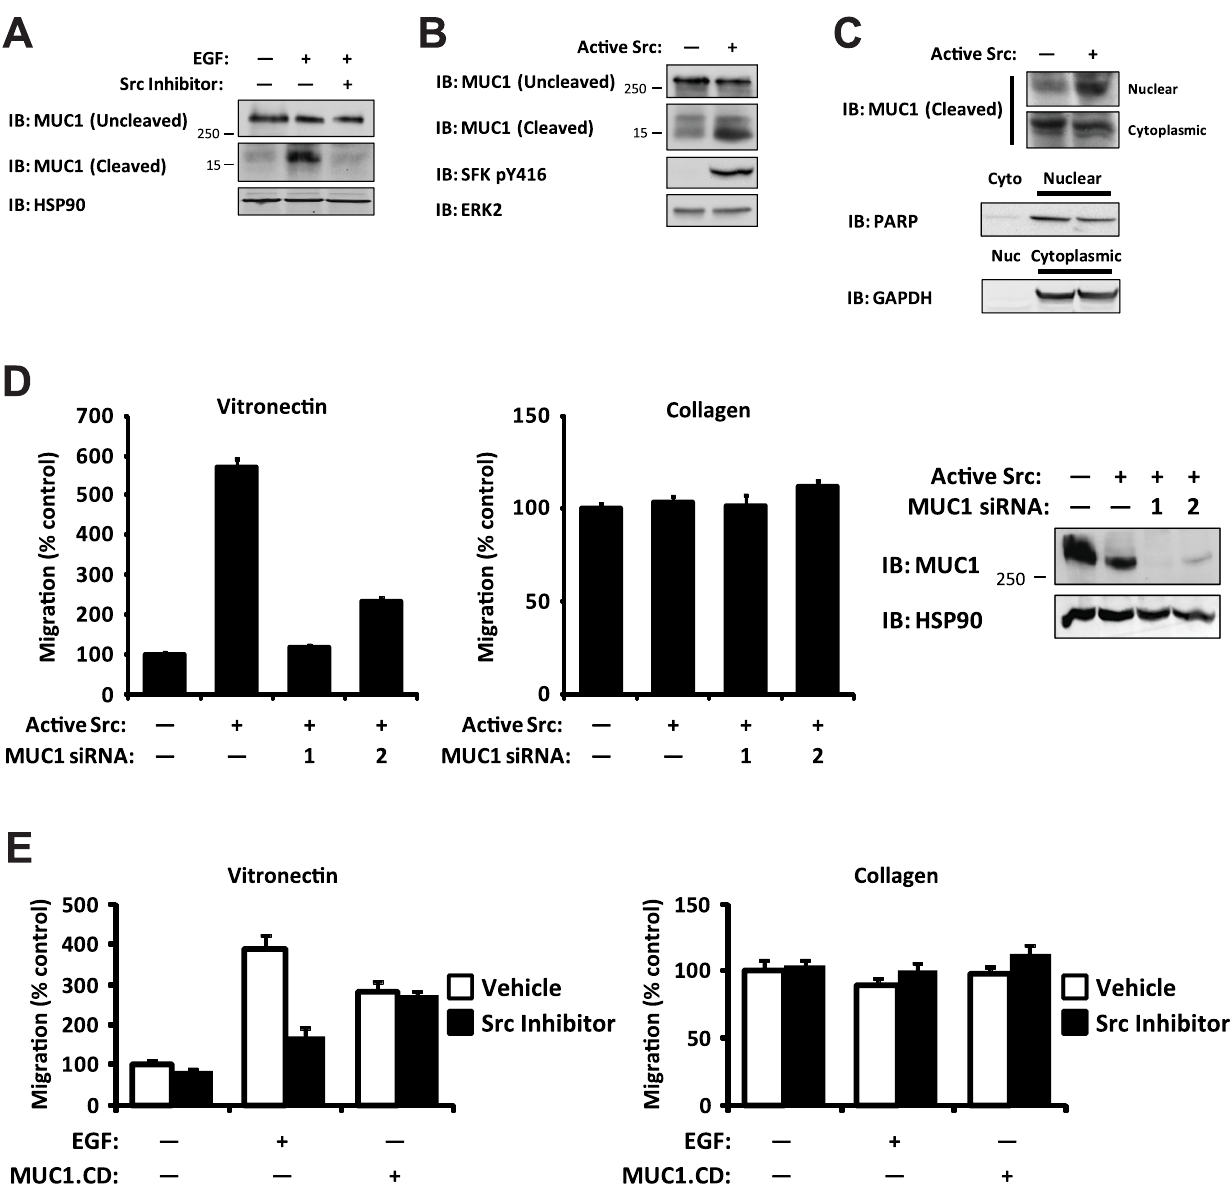
Figure 5. Src activity is necessary and sufficient for MUC1 cleavage, and MUC1 is required for Src-dependent migration. ( a ) Immunoblot detecting MUC1 cytoplasmic domain showing pre-treatment with a Src inhibitor (bosutinib, 500 nM) blocks EGF-dependent MUC1 cleavage in whole-cell lysates from FG cells. ( b ) Immunoblot detecting MUC1 cytoplasmic domain showing increased levels of cleavage product in FG cells expressing constitutively active Src compared to vector control. ( c ) Immunoblot detecting MUC1 cytoplasmic domain showing enrichment of MUC1 cytoplasmic domain in the nuclear fraction from FG cells expressing constitutively active Src compared to vector control. Fraction purity and loading were determined by immunoblotting for PARP (Nuclear, Nuc) and GAPDH (Cytoplasmic, Cyto). ( d ) Migration assays on a vitronectin (left) or a collagen (right) substrate in a Boyden chamber comparing FG cells co-expressing constitutively active Src and either a control siRNA or one of two different MUC1 siRNAs. Immunoblot detecting MUC1 expression (far right). P , 0.0001 comparing migration on vitronectin for cells expressing vector control or active Src; P , 0.0001 comparing migration on vitronectin for cells expressing control siRNA or either MUC1 siRNA; P =0.2 comparing migration on collagen across groups. ( e ) Migration assays on a vitronectin (left) or a collagen (right) substrate in a Boyden chamber comparing FG cells expressing either vector control or MUC1.CD with or without a 15 minute pre-treatment of EGF in the presence or absence of a Src inhibitor (bosutinib, 500 nM). P =0.7 comparing migration on vitronectin for cells expressing MUC1.CD with or without Src inhibitor treatment. Similar findings were observed in 3 independent experiments.